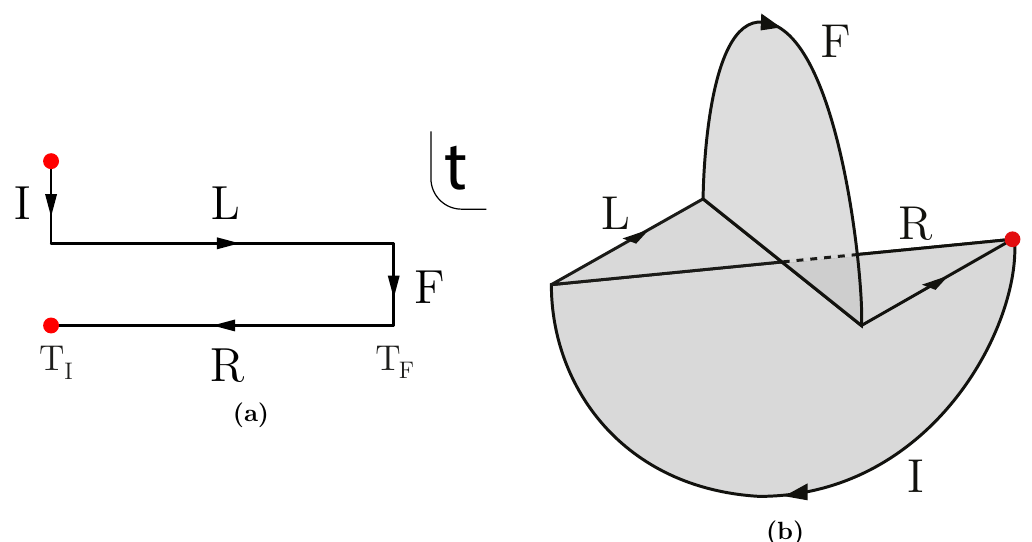
Figure 1 . (a) Closed Schwinger-Keldysh path in the complex t -plane. The horizontal lines represent real time evolution and the vertical lines give imaginary time evolution. Regions I and II have identical lengths equal to (cid:12)= 2. The red dots are identi(cid:12)ed, resulting in a closed path. (b) Dual bulk geometry (cid:12)lling the path on the left. The semicircular pieces represent the Euclidean sections, while the horizontal plane depicts the two sided AdS BH exterior represented as triangular wedges L and R. The arrows along the boundary display the path ordering shown in the left (cid:12)gure. The red dot from the path is also represented. Angular coordinates have been